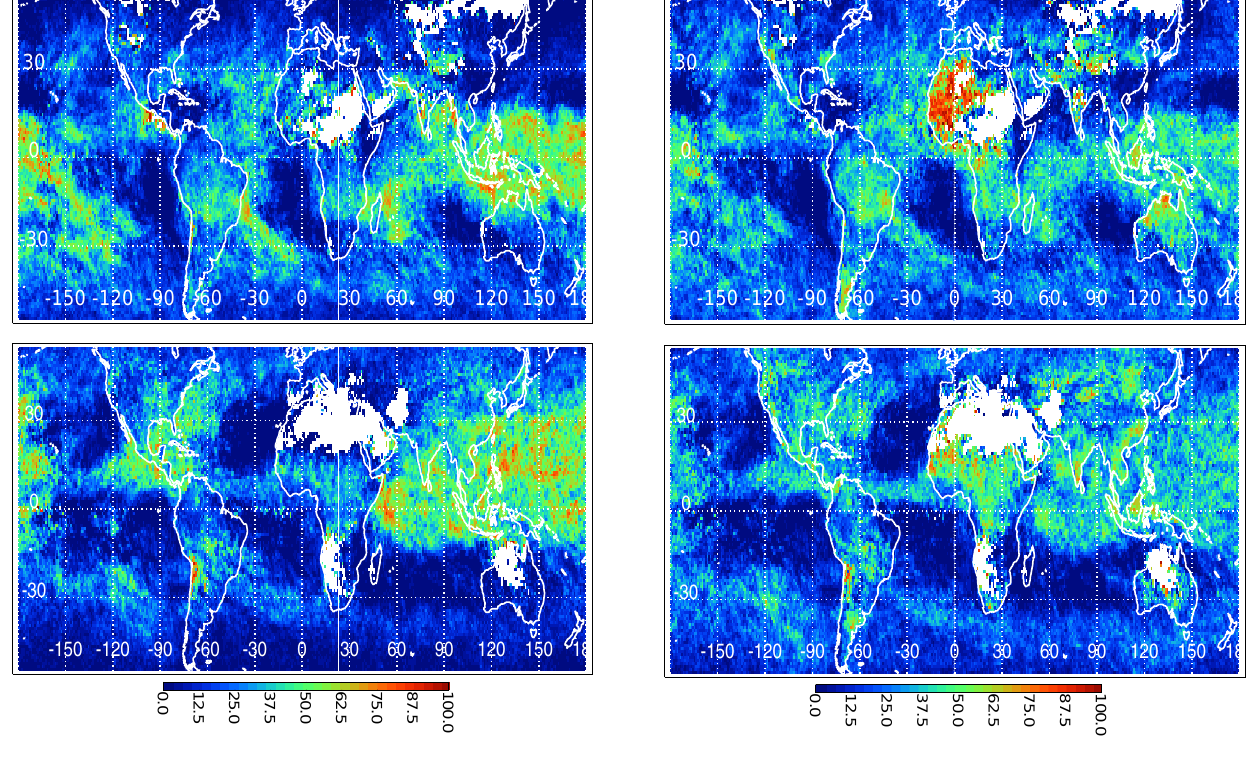
Fig. 12. Similar to Fig. 11 but results from MODIS-only on the OMI